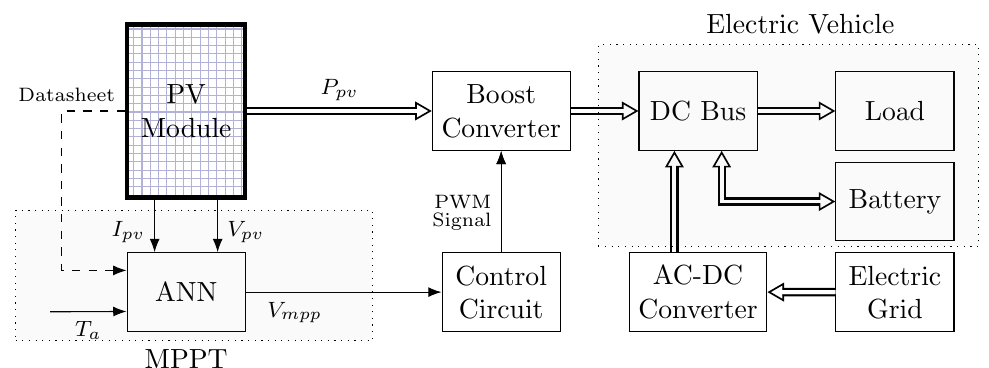
Figure 2. Photovoltaic system with MPPT controller connected to a DC-bus in a electric vehicle.